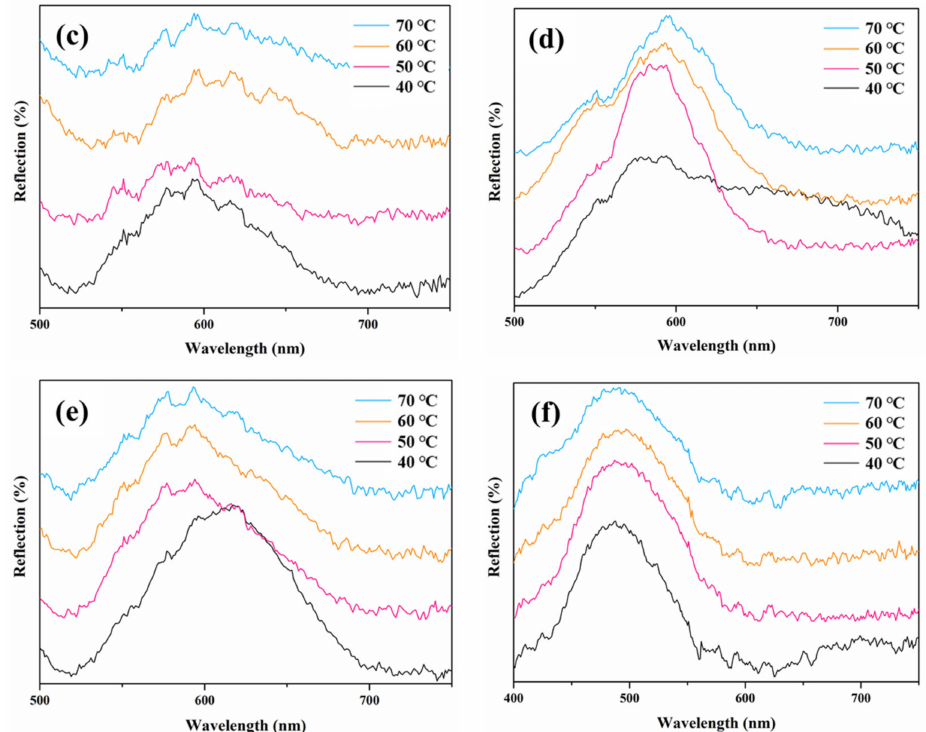
Figure 6. Reflectance spectra of coatings formed by self-assembly of PSt-based colloidal microspheres on a wood surface at 40, 50, 60, and 70 ◦ C; ( a ) PSt, ( b ) P(St-AA), ( c ) P(St-MMA-AA), ( d ) P(St-MMA), ( e ) P(St-BA-AA), and ( f )